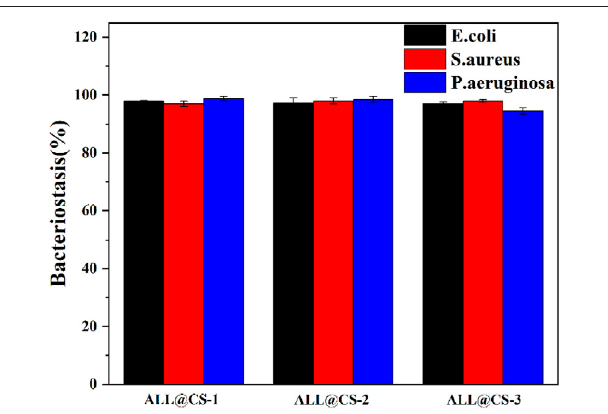
FIGURE 2 | Bacteriostasis of different ALL@CS nanocapsules against E. coli , S. aureus , and P. aeruginosa